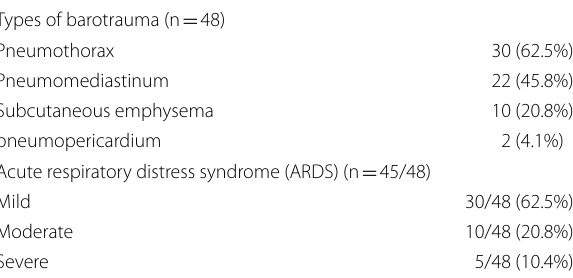
Table 2 Types of barotrauma and categories of